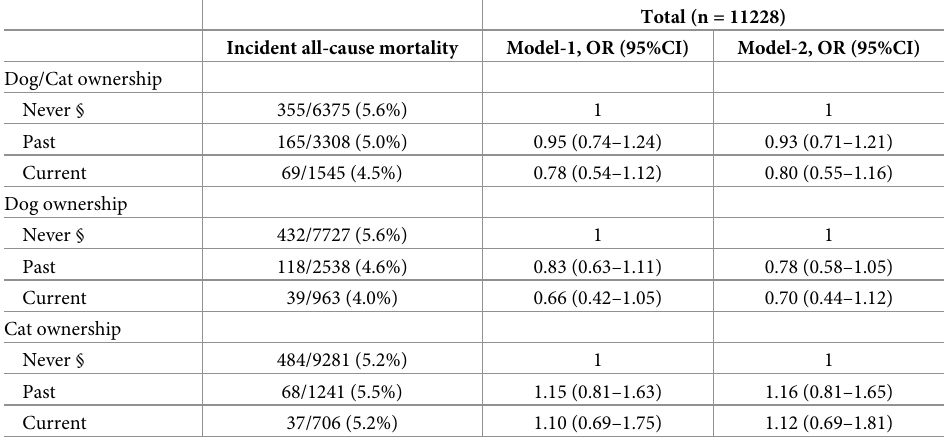
Table 3. Logistic regression models estimating the net effects of dog and cat ownership on all-cause mortality. Model 1 controls for socio-demographic variables.; Model 2 also adds controls for health at